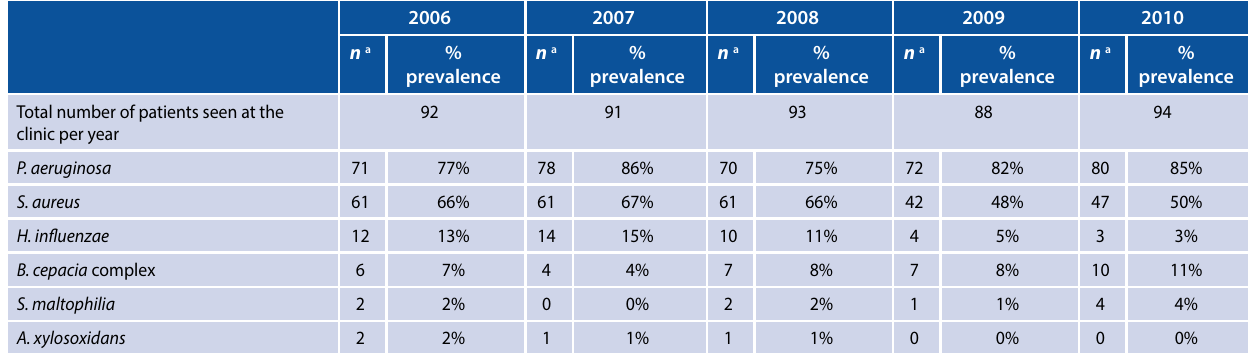
Note: a Number of patients with a positive culture for the pathogen of interest per year over total number of patients seen at the clinic that year, expressed as a percentage.